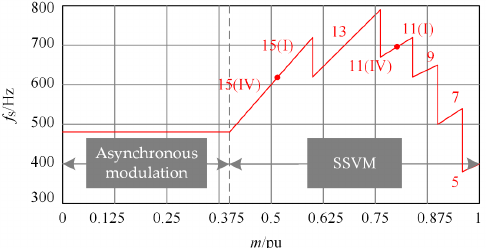
Figure 3. The variation of pulse number with the change of modulation index.